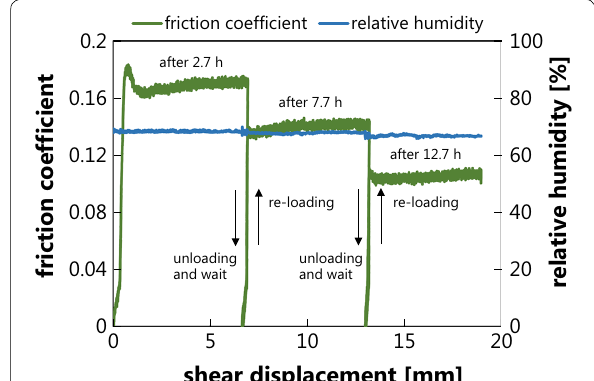
Fig. 3 Changes in the frictional coefficient of Na-montmorillonite with different time of 2.7, 7.7 and 12.7 h after achieving a constant relative humidity